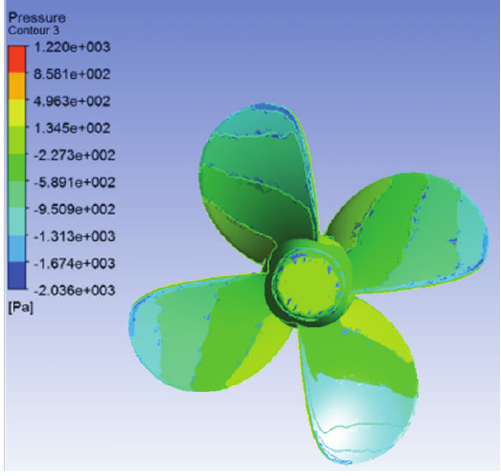
Figure 9: Pressure contour on suction surface (𝐽 = 1) .